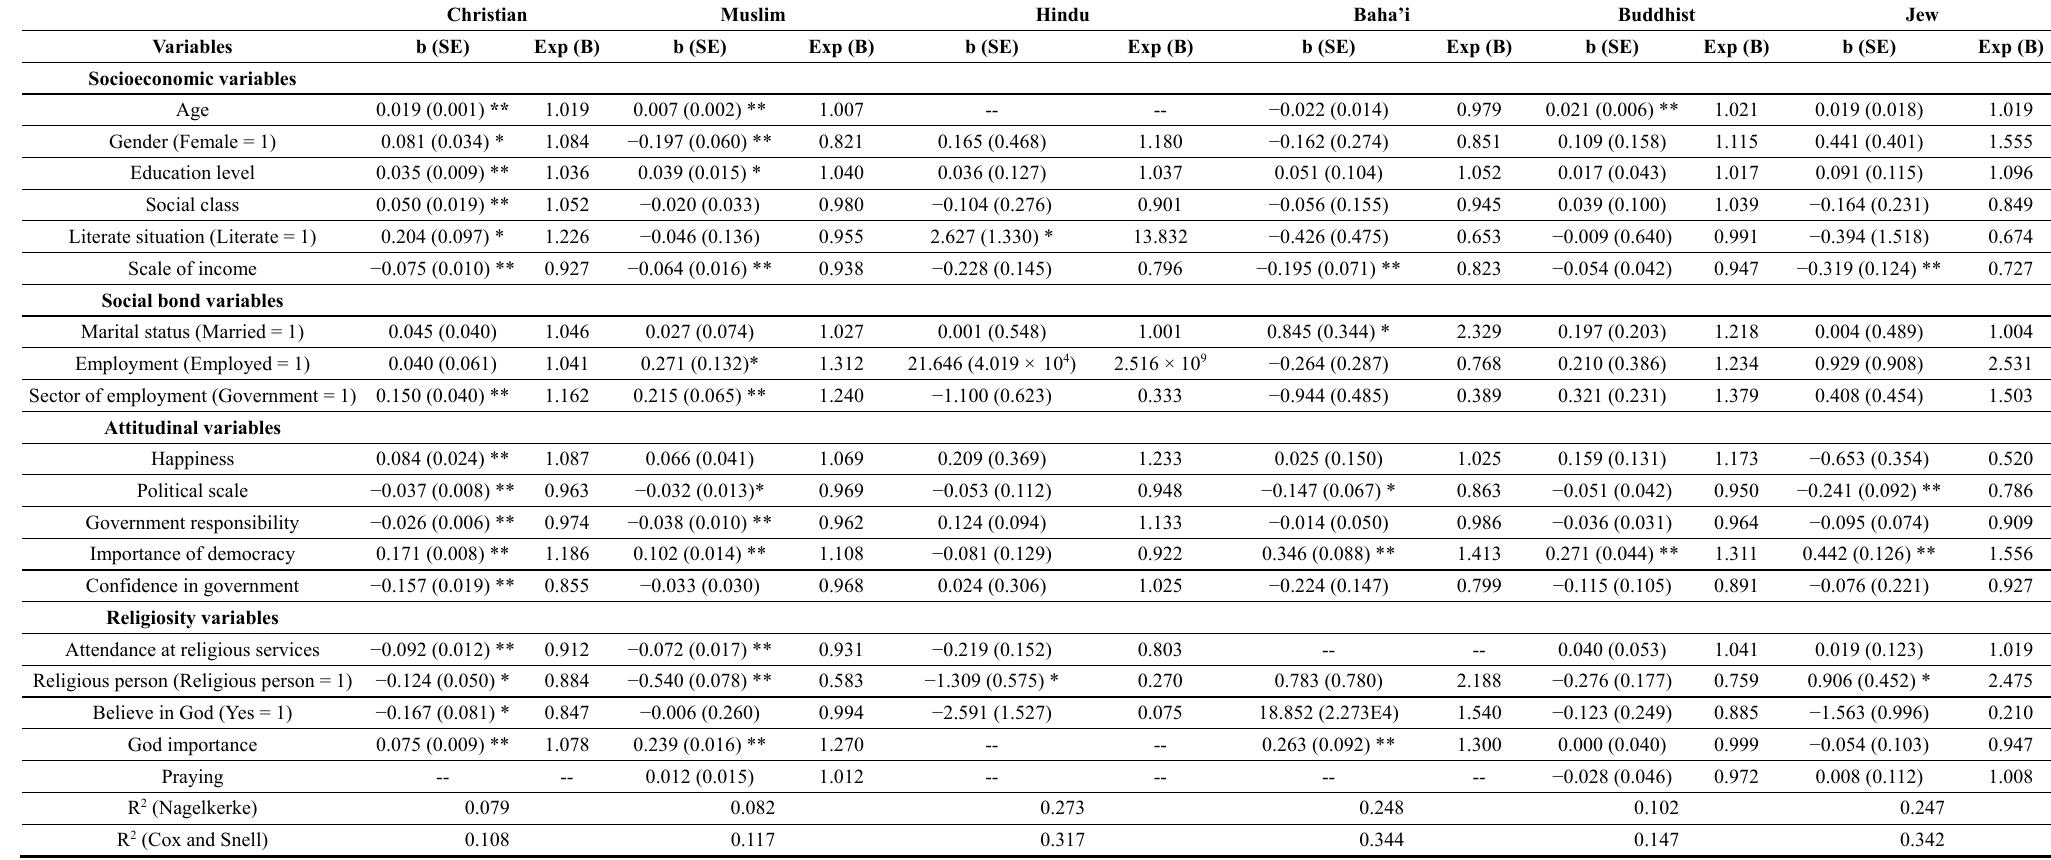
Table 3. Logistic regression results of religions and attitudes towards accepting a